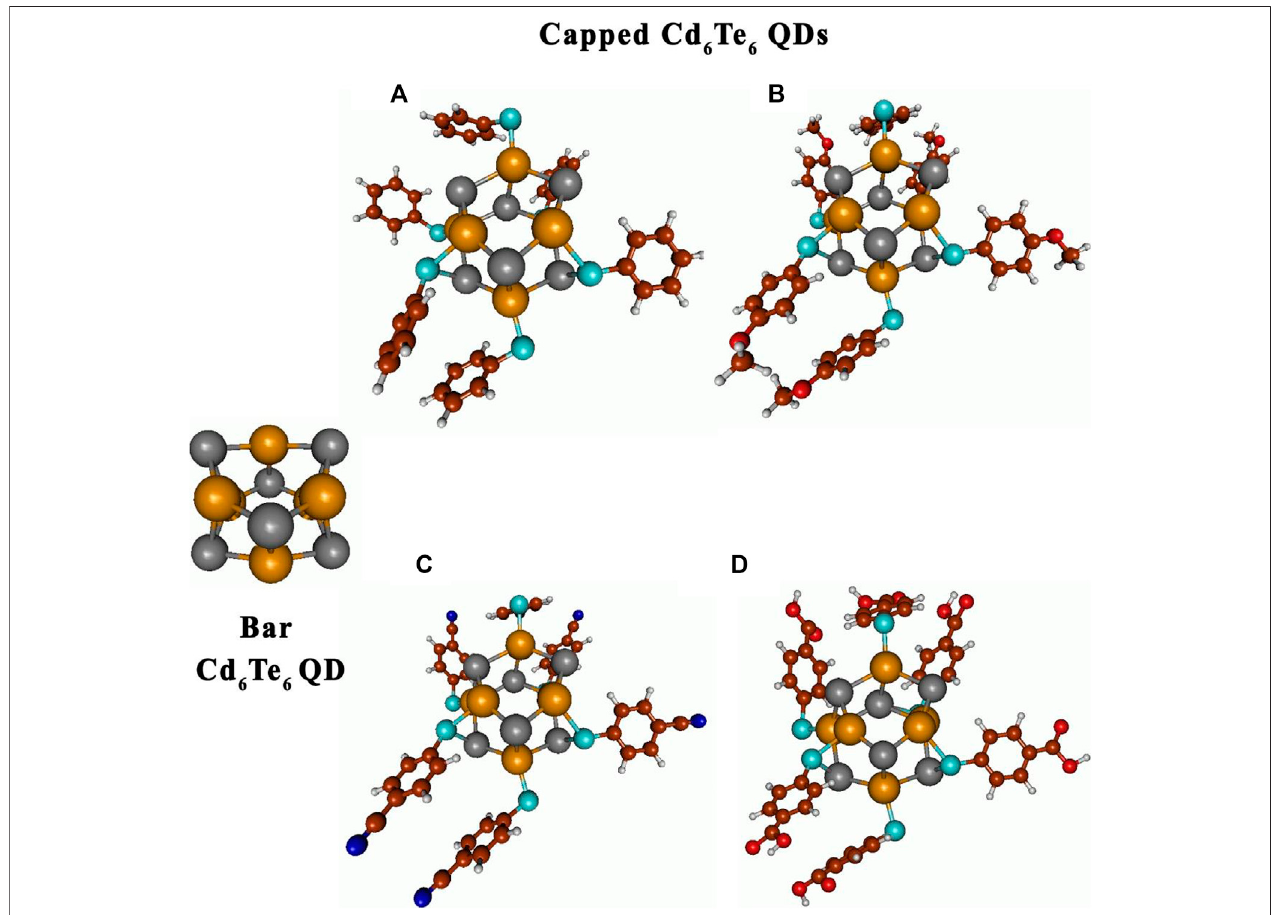
FIGURE 3 | Optimized gas-phase structures of bare and capped Cd 6 Te 6 QDs: Cd 6 Te 6 (TP) 6 (A) , Cd 6 Te 6 (MBT) 6 (B) , Cd 6 Te 6 (MBN) 6 (C) , and Cd 6 Te 6 (MBA) 6 (D) . Atomsarerepresentedasfollows:Cdbydarkyellowspheres,Tebydarkgrayspheres,Cbrownspheres,Hlightgraysphere,Oredspheres,Ssapphirespheres,andN blue